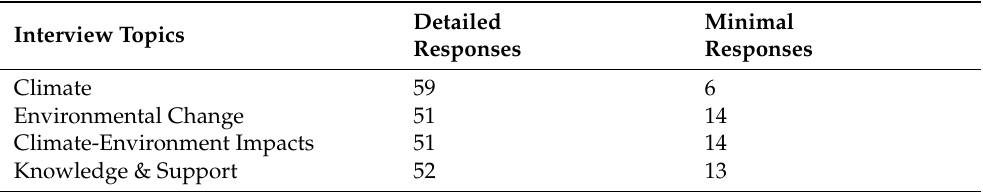
Table 2. Responses to interview